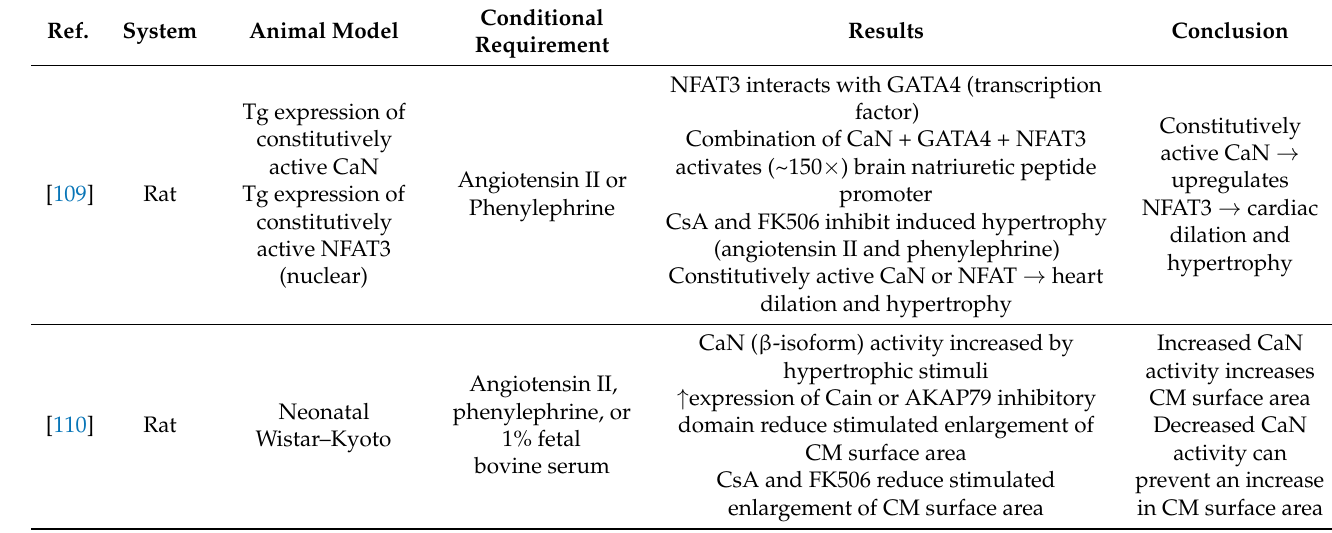
Table 3. Roles of calcineurin in cardiac